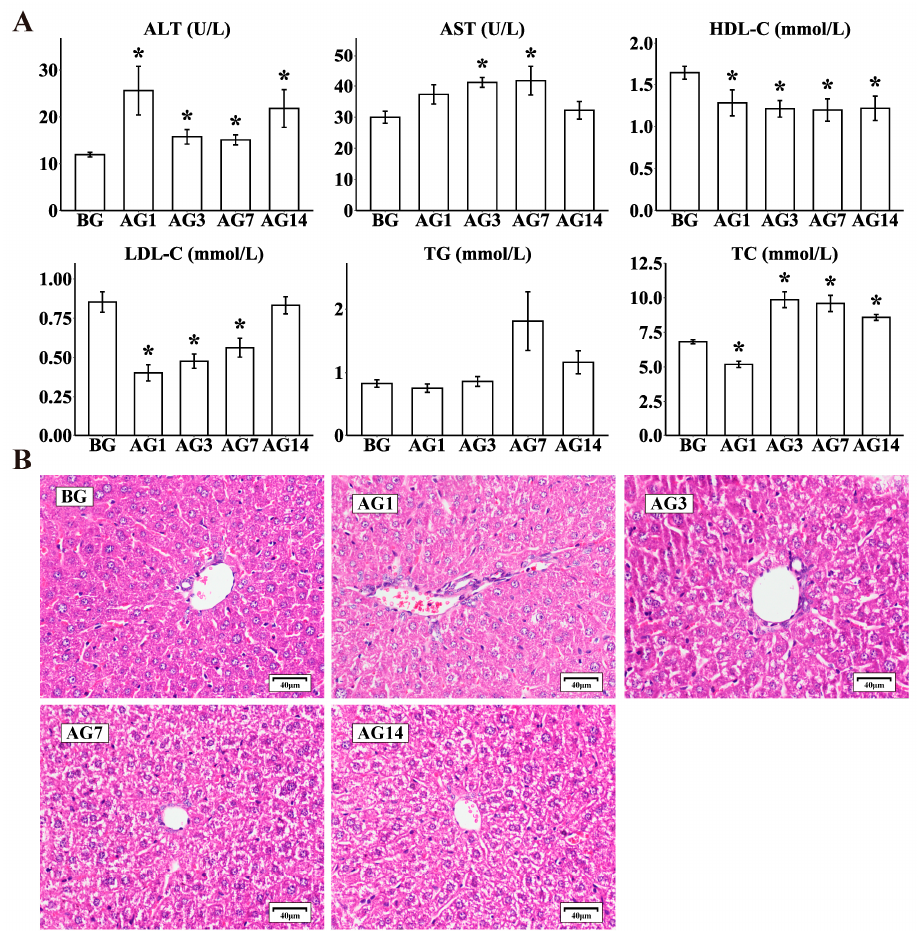
Figure 1. Serum index and HE staining of liver in mice with alcoholic liver injury. ( A ). Serum total cholesterol (TC), Triglyceride (TG), Low-Density Lipoprotein Cholesterol (LDL-C), High-density lipoprotein cholesterol (HDL-C), Alanine transaminase (ALT) and Serum aspartate aminotransferase (AST) were detected using a microplate technique (n = 10 per group), * p < 0.05 vs. BG. ( B ). Liver morphology was detected by hematoxylin-eosin (H&E). Scale bar = 40 μ m. 2.2. Single-Cell Expression Atlas of Healthy and Alcoholic Liver Injury Mouse Livers To elucidate liver cell complexity, heterogeneity and their dynamic changes in the pathogenesis of alcoholic liver injury, scRNA-seq was performed on liver cells from healthy and alcoholic liver injury mice at different times. Each cell had on average 33,918 reads and the exon reads took up 70.94% of the total reads. After removing low-quality cells, 50,274 single-cell transcriptomes were reserved and analyzed, including 10,439 from BG group, 10,164 from AG1 group, 9459 from AG3 group, 9260 from AG7 group, and 10,952 from AG14 group (Table S1). Subsequently, the expression matrix of each cell was created and analyzed using the Seurat R package. t-SNE plot showed that the liver cells were evenly distributed in each group, no significant intergroup batch effect was observed among the 5 groups (Figure S2A). A total of 38 clusters were identified with a resolution of 0.8 (Figure S2B). All liver cells could be assigned to 12 major liver cell types based on the expression of marker genemarker gene expression and SingleR package (version 2.0.0) (Figure 2A,B). They were B cells (B, marked with Ms4a1 ), Cycling (marked with Birc5 ), dendritic cells (DCs, marked with Slglech ), endothelial cells (Endo, marked with Kdr ),